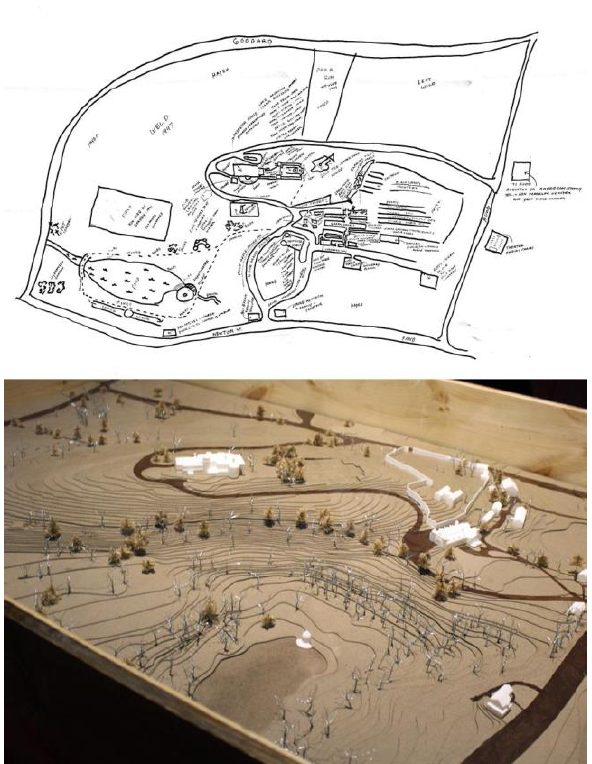
Figure 8. Sketch of the original estate & completed site model